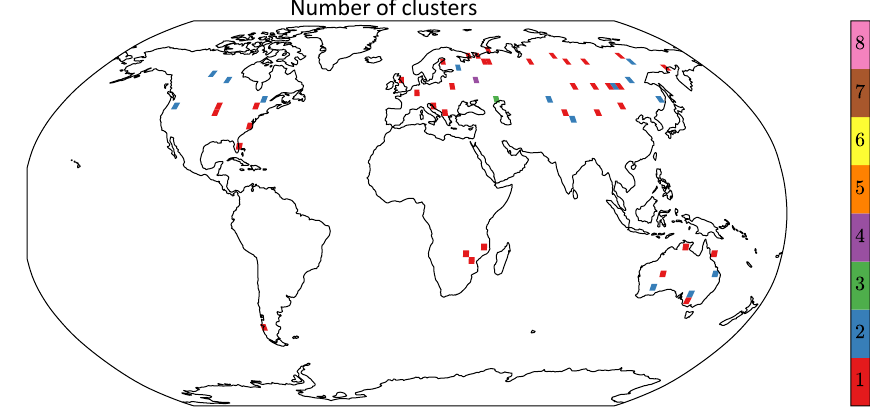
Figure A1. Map of the number of clusters for all CLASS-CTEM grid cells where the weighted mean of the clusters was more than 10% different than the simple mean of all GSDE grid cells within a CLASS-CTEM grid cell. These grid cells were then assigned the simple Gridmean soil texture values for all simulations (see Sect. 2.3.1).